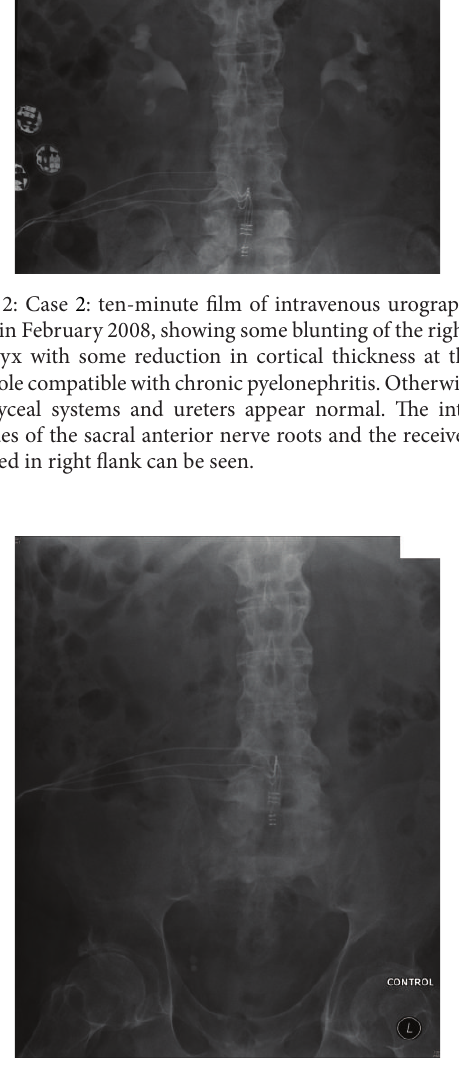
Figure 3: Case 3: X-ray kidneys and urinary bladder, taken in Sep- tember 2009, showing no radioopaque urinary calculi. The receiver blockwhichhadbeenimplantedintherightflankhadbeenremoved because of Staphylococcus aureus